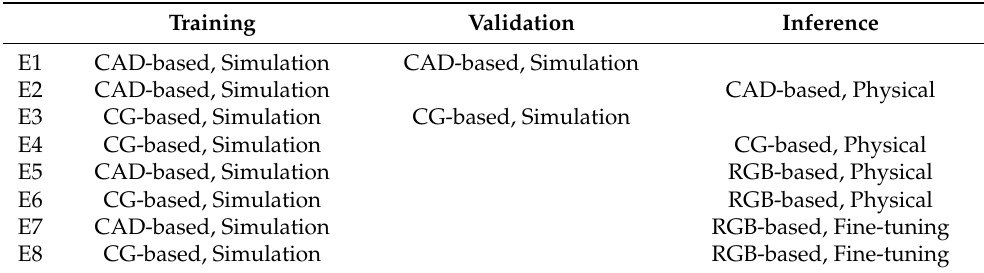
Table 1. Kinds of experiments described in this Section. There are three kinds of edge image generation methods: CAD-based, CG-based, and RGB-based. There are two types of pose generation: simulation and physical. Training means how to train the model. Validation means how to check valid training. Inference means how to estimate in a physical situation.